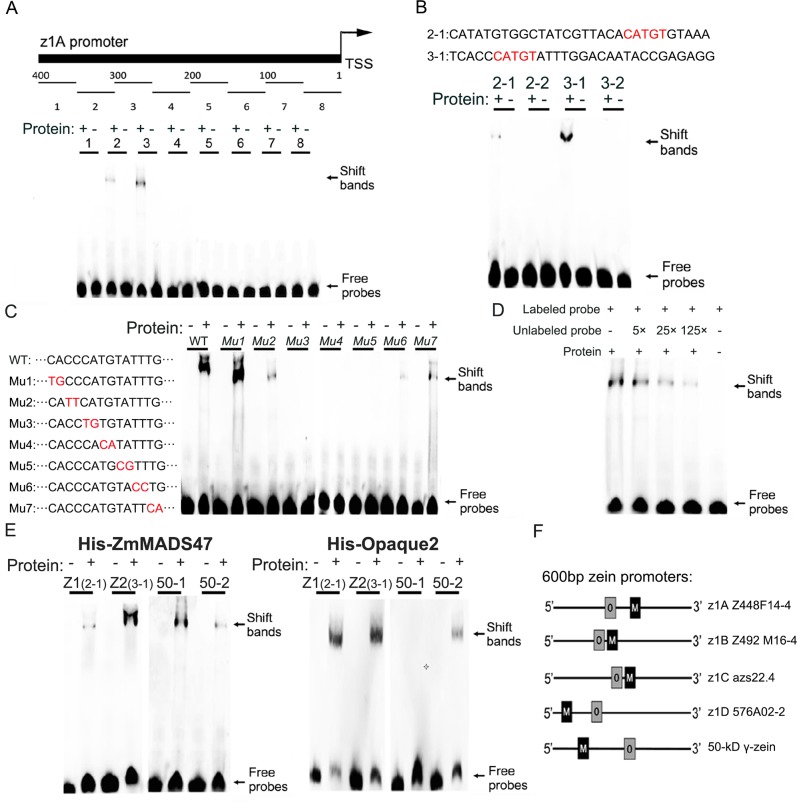
Characterization of the ZmMADS47 binding motif.A. Schematic representation of z1A promoter fragmentation. Black arrow points to the ZmMADS47-indused shift bands. B. Deletion analysis to narrow down the conserved domain recognized by ZmMADS47. The upper black arrow identifies the shifted bands due to the ZmMADS47/DNA complex. The bases highlighted by red letters represent the sharing sequences in both two fragments. C. Mutagenesis assay of CATGT motifs. The upper black arrow identified the shifted bands due to the ZmMADS47/DNA complex. The bases highlighted by red letters represent the mutational bases compared with wild-type bases. D. Effect of competitive probe on the band shift reaction. The upper black arrow identifies the shifted bands due to ZmMADS47/DNA complex. E. The binding ability of His-ZmMADS47 and His-O2 to CATGT motifs in the z1A promoter and 50-kD zein promoter. The experiment was performed by adding ZmMADS47 or O2 protein. The upper black arrow identifies shifted bands due to ZmMADS47/DNA complex or O2/DNA complex. F. Schematic representation of ZmMADS47 binding site (M) and O2 DNA binding site (O) in down-regulated zein promoters.